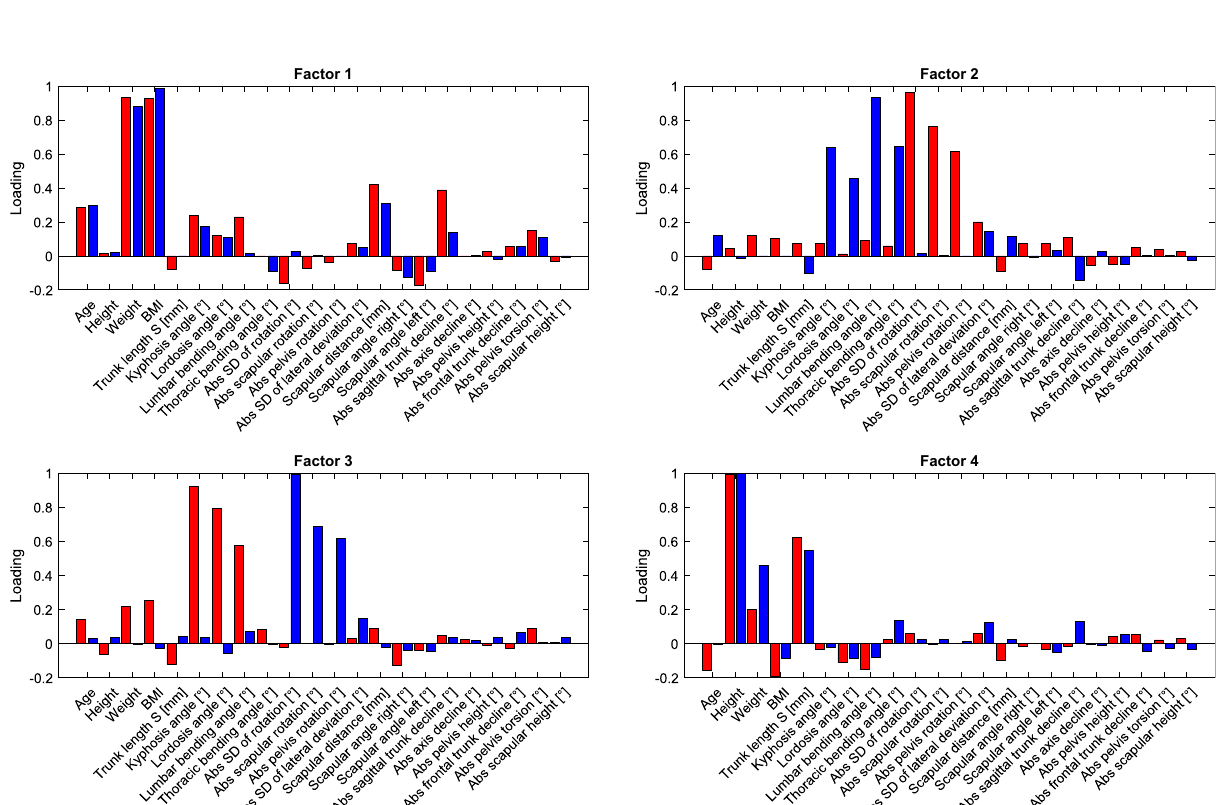
Figure 5. Factor loadings of the first 4 factors. The gender-specific factors were calculated for the two gender groups (red: female; blue: male). Legend Abs, Absolute